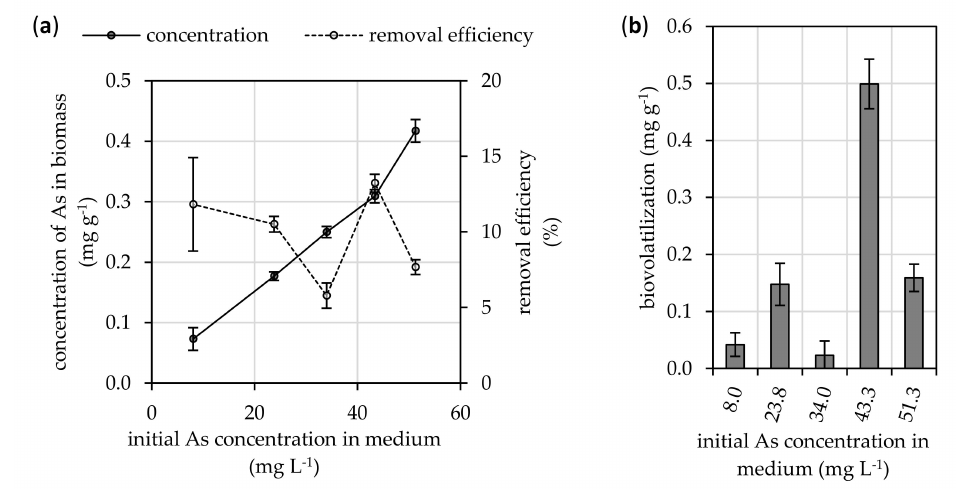
Figure 2. E ff ects of initial arsenic concentration in a culture medium on its ( a ) bioaccumulation and ( b ) biovolatilization by the fungal Aspergillus niger strain during a 19-day static cultivation period at 25 ◦ C. Results represent the mean values of four independent experiments, and the error bars show the standard deviation.